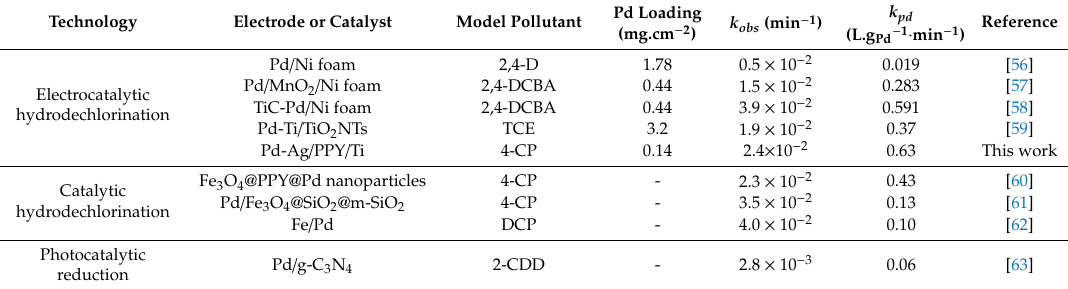
Table 2. Comparison of equivalent conversion rate constants under di ff erent